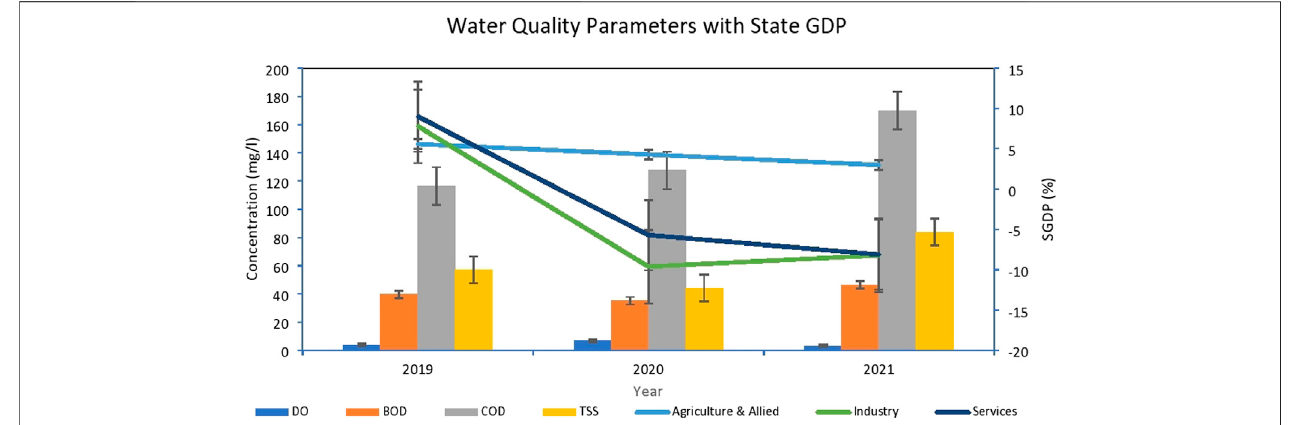
FIGURE 1 | Water quality parameters with state GDP for the respective years.